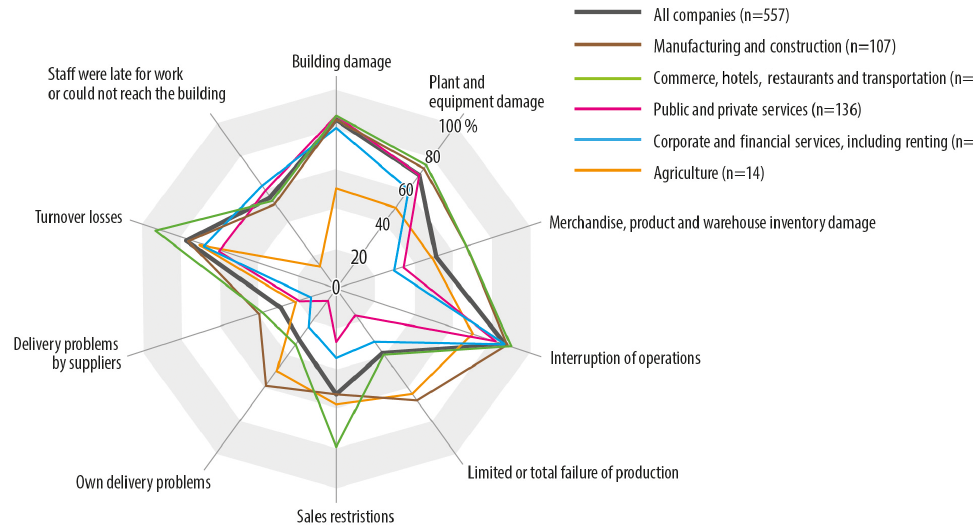
Figure 9. Share of surveyed companies that reported on the different flood impacts.